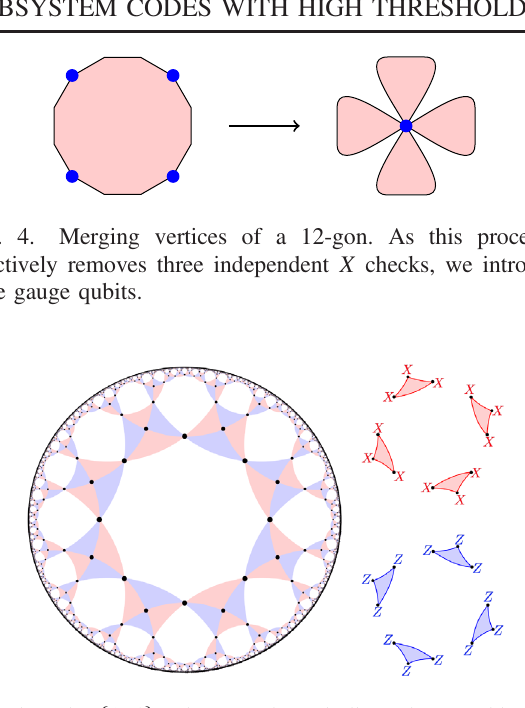
FIG. 5. The f 8 ; 4 g subsystem hyperbolic code. A qubit (each represented by a black-filled circle) is placed in the center of each edge and on each vertex of an f 8 ; 4 g tessellation of a closed hyperbolic surface. A three-qubit triangle operator is placed in each corner of each face. Each X stabilizer is the product of the four X triangle operators within a face (top right). Similarly, each Z stabilizer is the product of the four Z triangle operators within a face (bottom